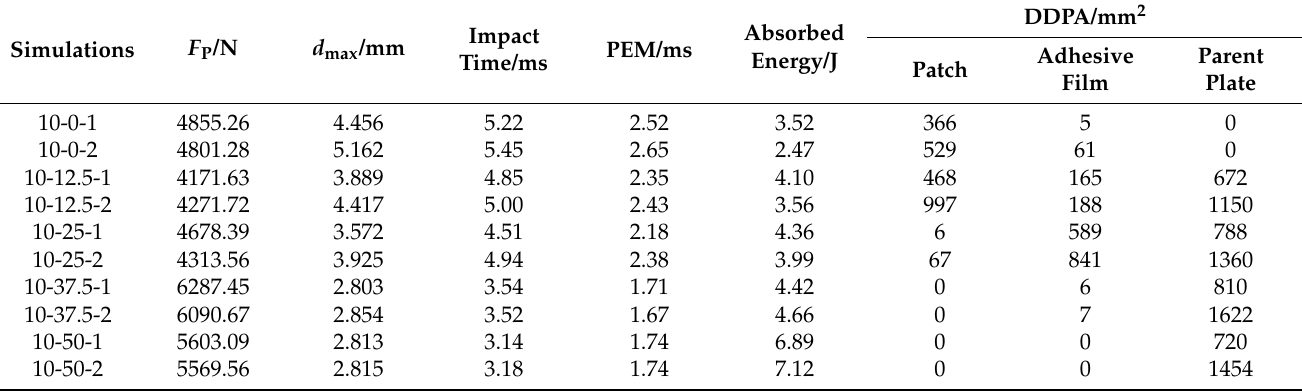
Table 4. Impact parameters under double impacts at impact distances of 0 mm–50 mm, with the impact energy of 10